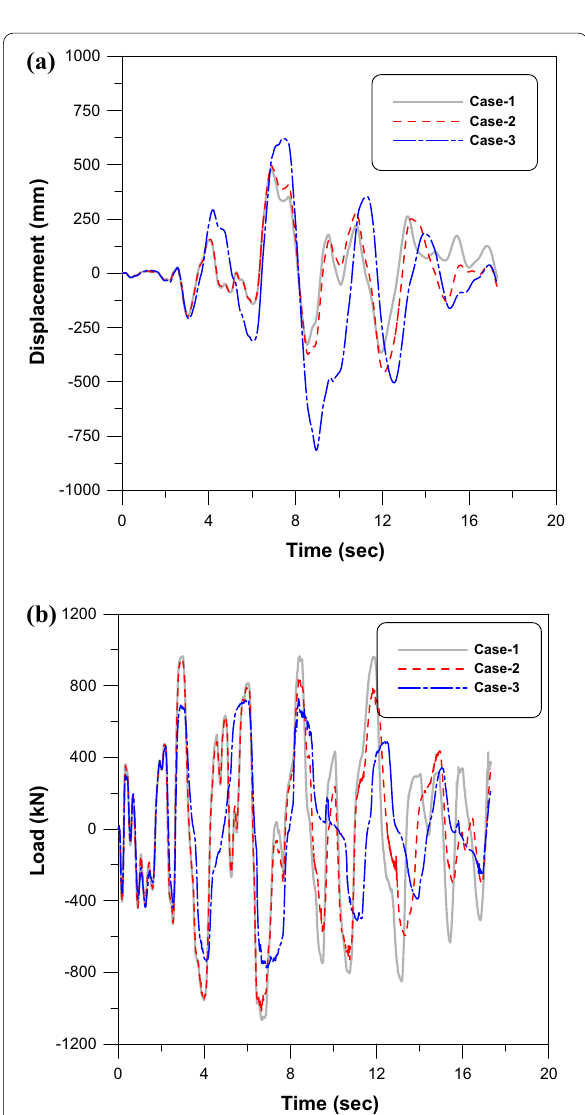
Fig. 11 Seismic response for Case‑1, Case‑2, Case‑3: a displacement and b